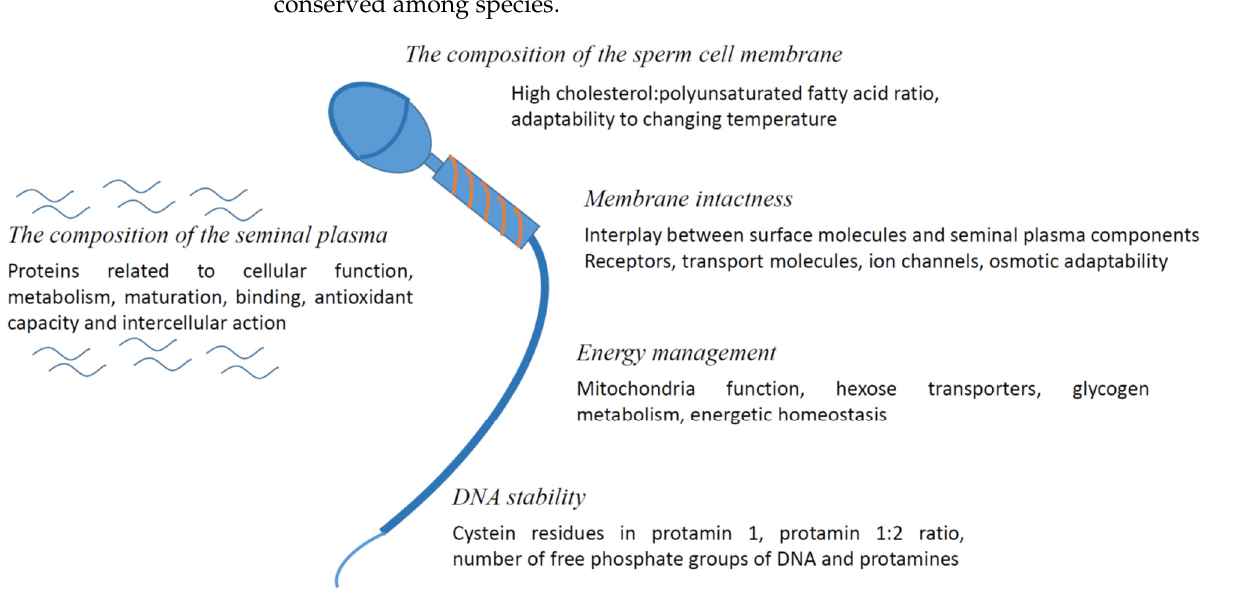
Figure 1. What makes sperm